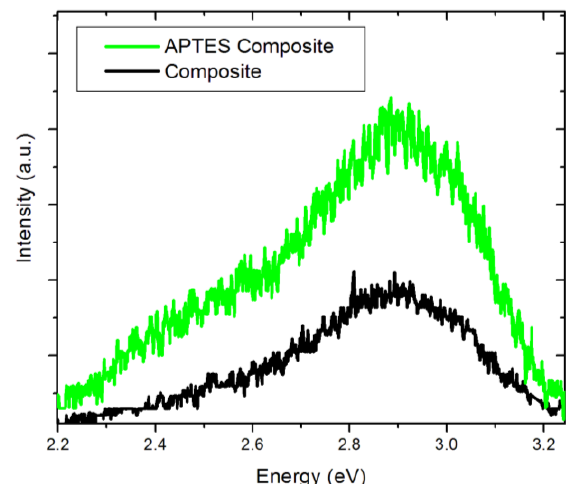
Figure 10. The effects of synthesizing the nanocomposite with and without the APTES modification step on the PL